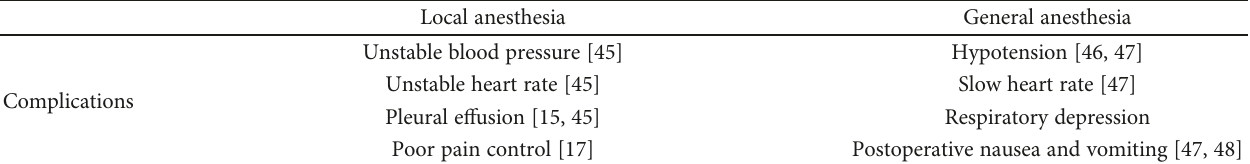
Table 2: Comparison of local anesthesia and general anesthesia complications in interventional